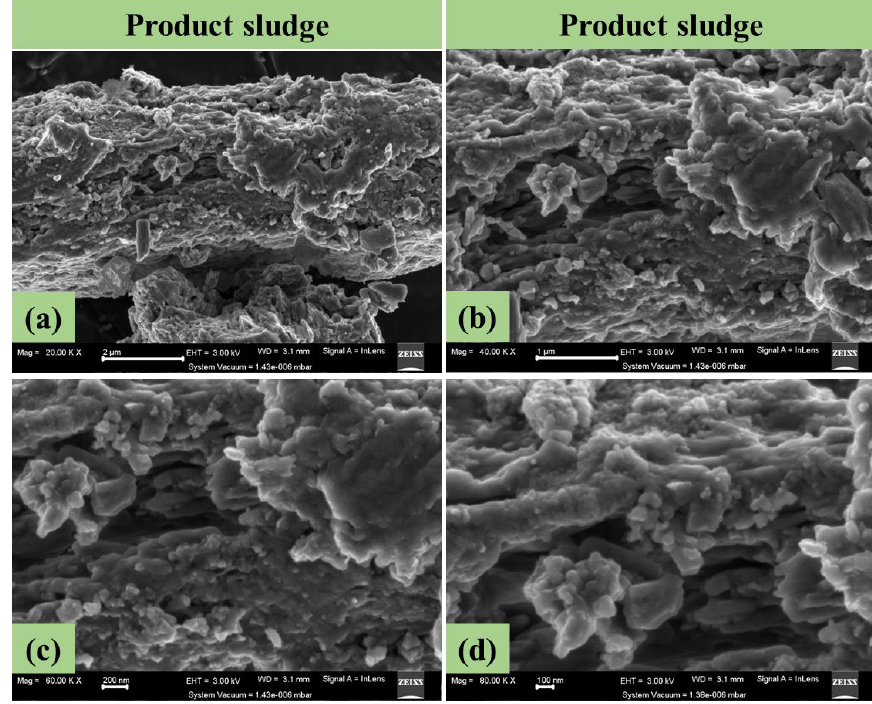
Figure 4. Microstructural and morphological properties of the product sludge at ( a ) 2 μm, ( b ) 1 μm, ( c ) 200 nm, and ( d ) 100 nm magnification.